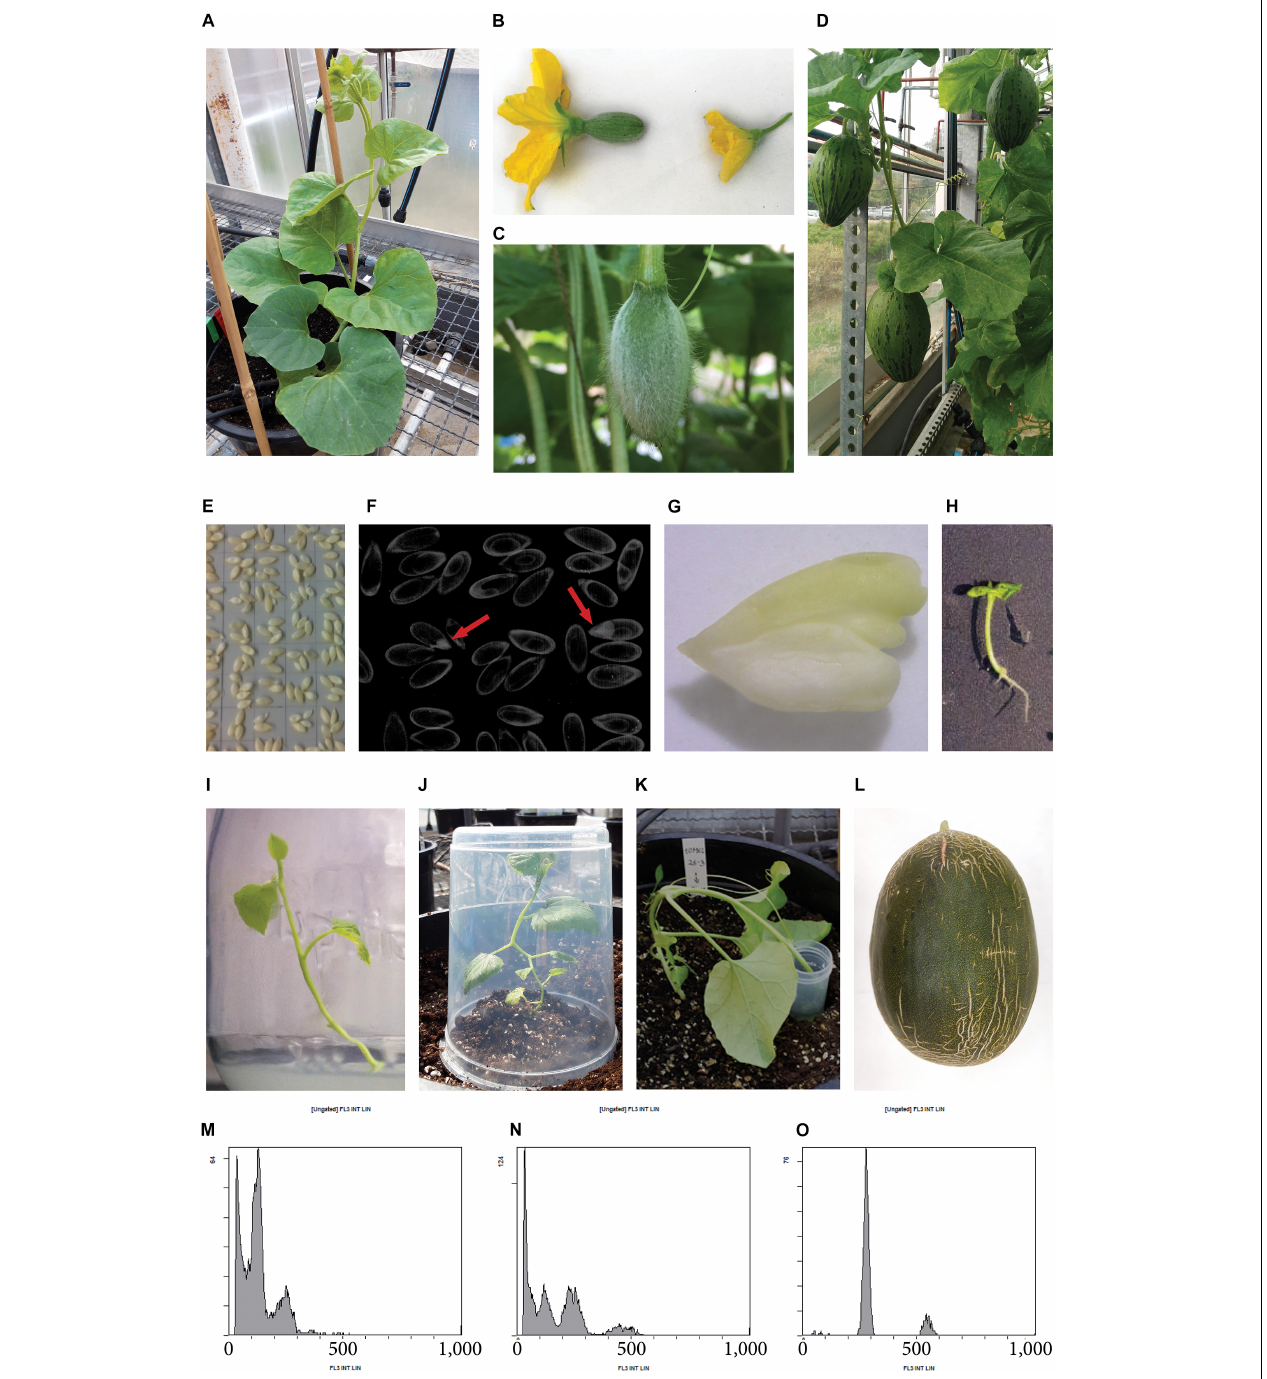
FIGURE 1 | Production of parthenogenetic DH lines in melon “Piel de Sapo” genotype. (A) Melon donor plant. (B) Detail of a female flower (left) and a male flower (right) . (C) Female flower developed after pollination with irradiated pollen. (D) Melon fruits set after 3 weeks of pollination with irradiated pollen, which potentially contain parthenogenetic embryos in their seeds. (E) Melon seeds in an acetate sheet ready to be photographed by X-ray. (F) X-ray photography of seeds, parthenogenetic embryos are pointed with a red arrow. (G) Parthenogenetic embryo rescued. (H) Germinated embryo in vitro . (I) Micropropagated melon plantlet. (J) Acclimated melon plant covered with a plastic pot to avoid dryness. (K) In vivo chromosome doubling treatment of a haploid plant by immersion of the apical meristem into a colchicine solution. (L) Melon fruit of a DH line. (M) Flow cytometry histogram of a haploid plant, showing ploidy-peaks at channels 150 and 300, corresponding to haploid cells in G0 phase and G2 phase, respectively. (N) Flow cytometry histogram of a mixoploid plant, showing ploidy-peaks at channels 150, 300, and 600, corresponding to haploid cells in G0 phase, diploid cells in G0 phase and haploid cells in G2 phase, and, diploid cells in G2 phase, respectively. (O) Flow cytometry histogram of a DH plant, showing ploidy-peaks at channels 300 and 600, corresponding to diploid cells in G0 phase and G2 phase, respectively.